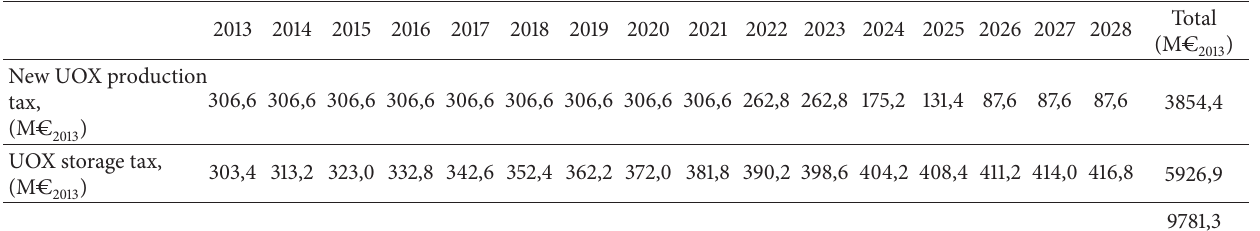
Table 1: Cash flows for the year 2013 by type of tax and year and the total cash flows. Once-Through Cycle.